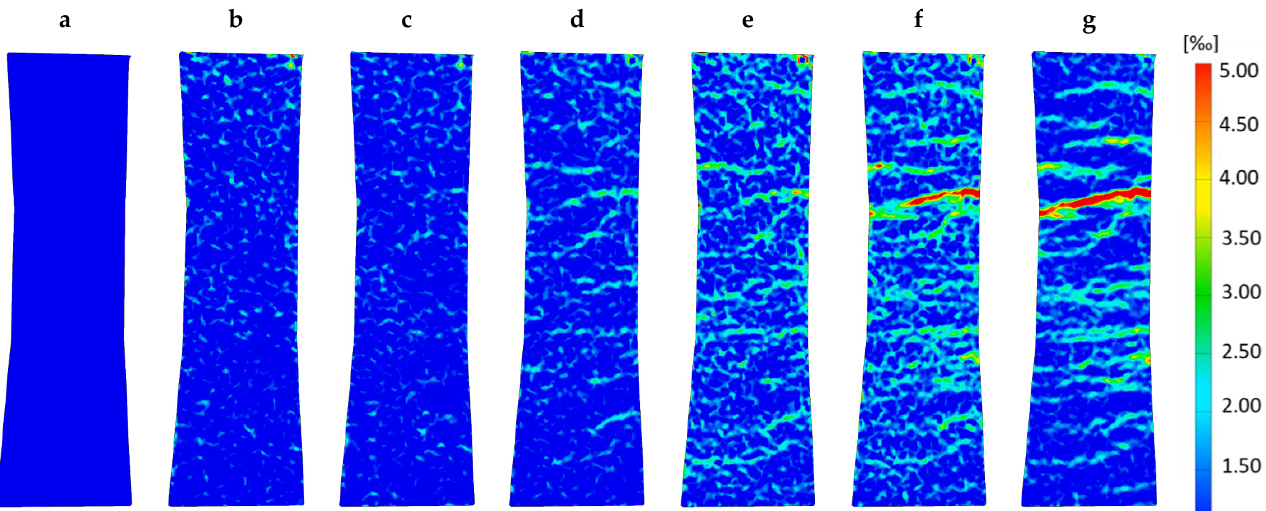
Figure 13. DIC evaluation at stages ( a – g ) (see Figure 12) displays strain on the specimen’s surface and shows the formation of multiple microcracks in a wide-spread area. Additionally, the evolution of the crack leading to failure can be observed in pictures ( d – g ). Small-sized local strain maxima (light blue) can be subjected to measuring noise. Point g marks an instable point where stress decreases while strain still